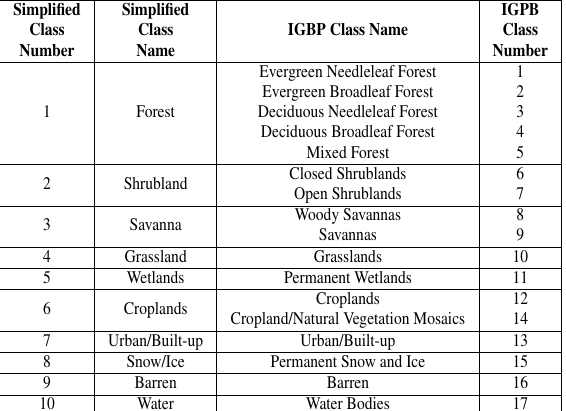
Table 1: The original and simplified IGBP Land Cover Classifi-